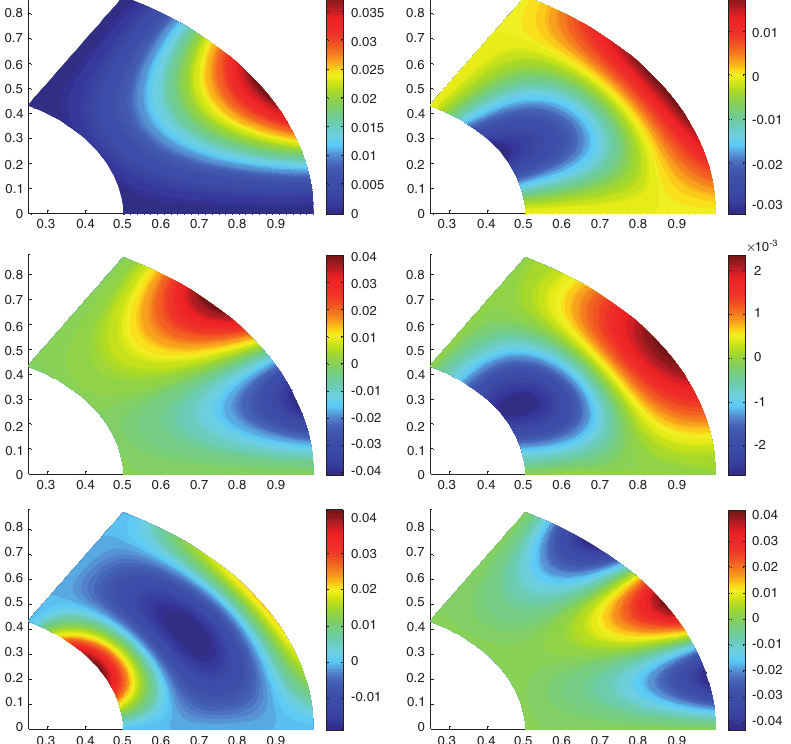
Figure 6 The first six mode shapes of an isotropic FG annular sector plate clamped at the radial edges for n = 1 and θ = 60 °